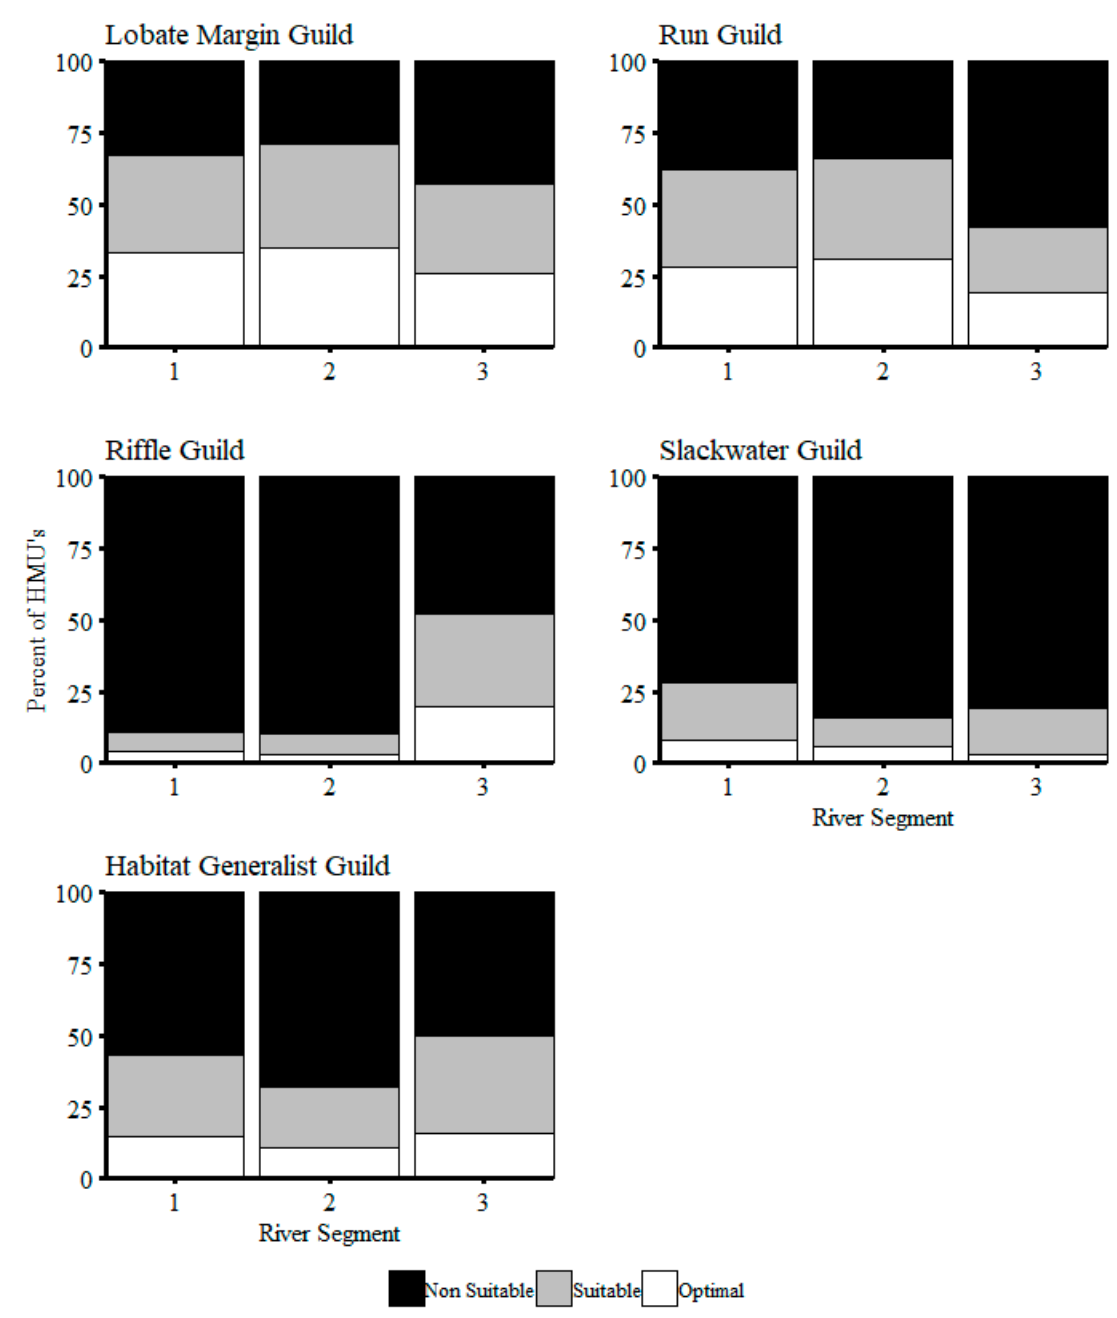
Figure 2. The percentage of hydromorphologic units (HMUs) estimated at non-suitable, optimal, or suitable for each fish guild across river segments of the Niobrara River using predictions from multiple logistic regression models.